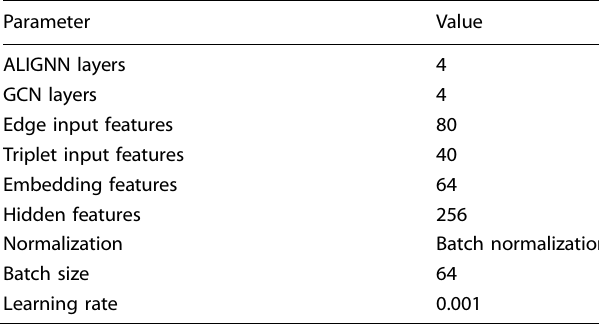
Table 1. ALIGNN model con fi guration used for both solid-state and molecular machine learning models.